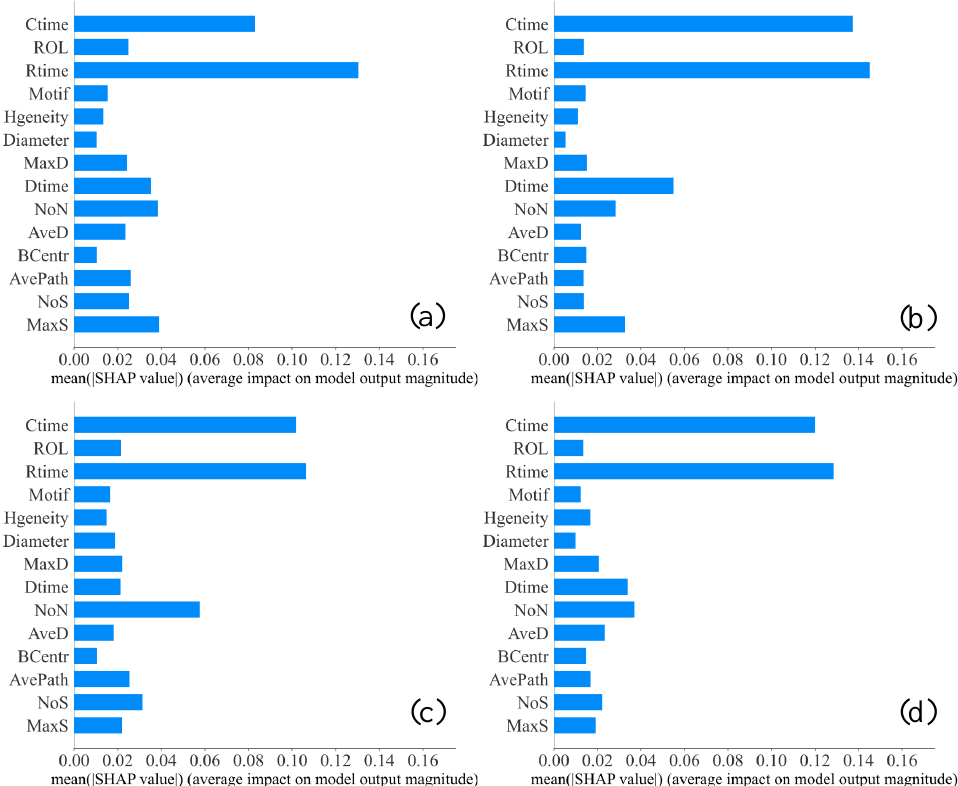
Figure 6. Mean ( | SHAP value | ) of the subsampled and original Twitter datasets for different cut-off times . ( a , b ) On the subsampled Twitter dataset, the cut-off time is 2.4 h and 12 h, respectively. ( c , d ) On the original Twitter dataset, the cut-off time is 2.4 h and 12 h,